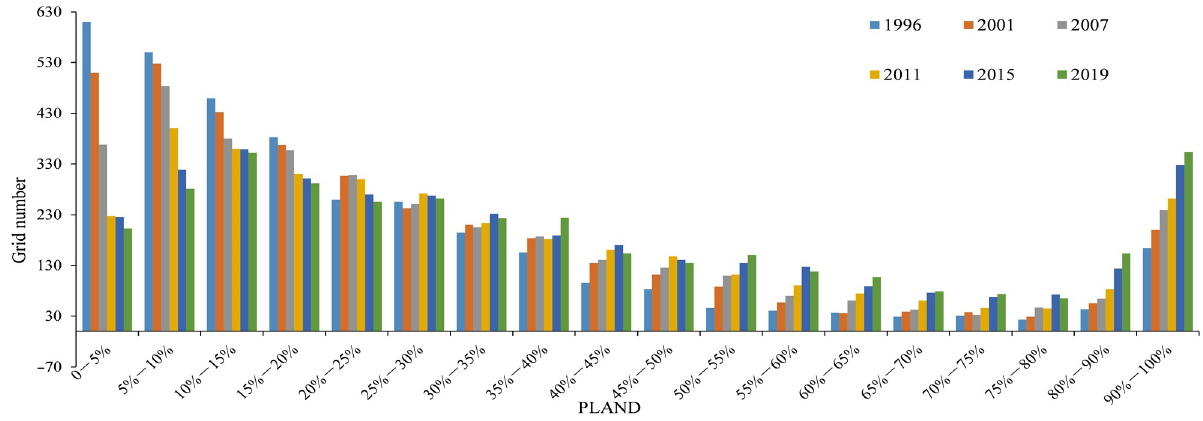
Figure 11. Statistics of sample grids of different percentages of built-up land (PLAND) types.